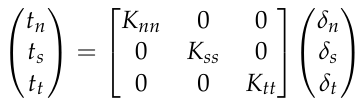
Figure 7. The linear relationship between fibre tensile and compression damage in the 3D Hashin VUMAT subroutine [29].